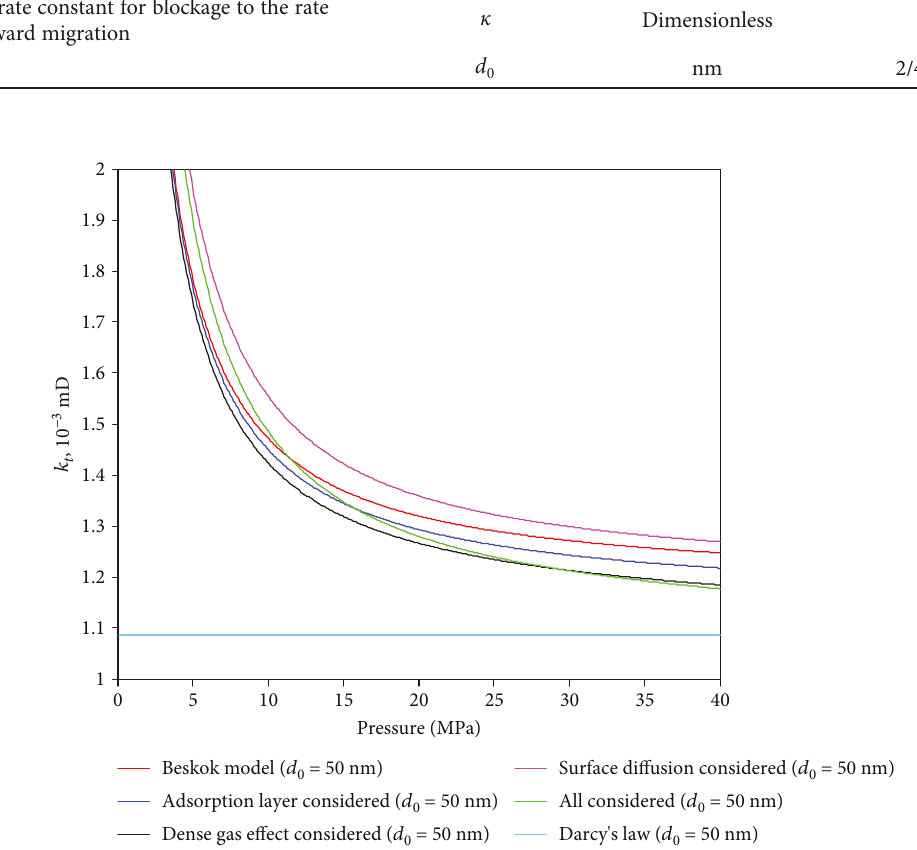
Figure 8: The e ff ect of di ff erent factors on total apparent permeability (pore diameter = 50 nm ).